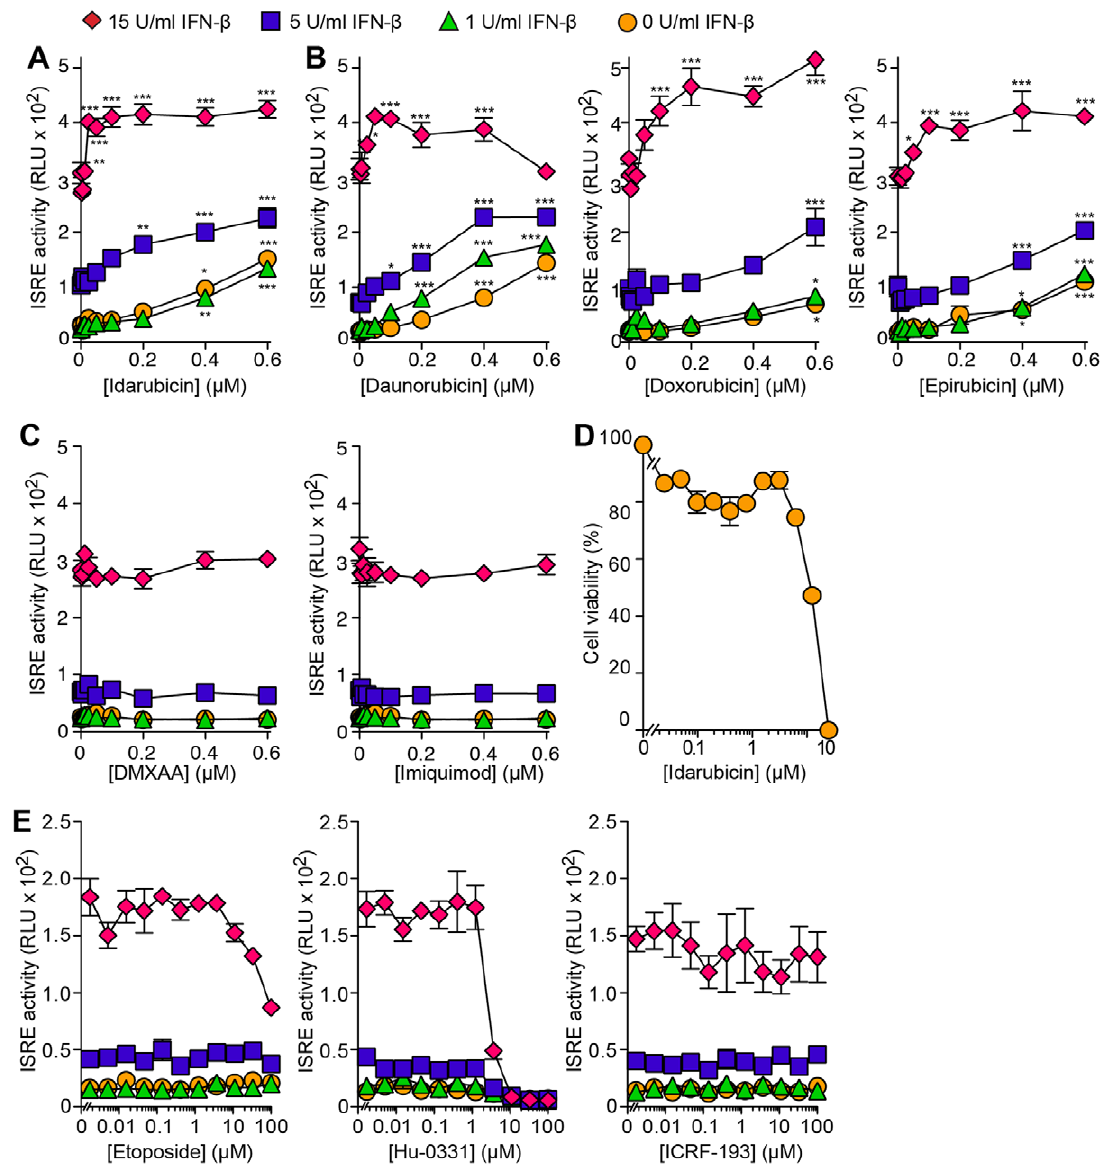
Figure 5. Validation and specifcity of idarubicin capacity for ISRE activation. (A) Idarubicin concentration-response for ISRE activity without and with treatment with IFN- b (1, 5, and 15 U/ml). 2fTGH-ISRE-CBG99 cells were treated with idarubicin and IFN- b for 8 h. Overall significance for idarubicin dose P , 0.0001, IFN- b dose p , 0.0001, and Interaction p , 0.0001. The p-values for individual comparisons (versus control without idarubicin) are from Bonferroni post-tests from two-way ANOVA (idarubicin x IFN dose). Symbols: * p , 0.05, ** p , 0.01, *** p , 0.001. (B) Corresponding data for daunorubicin, doxorubicin, and epirubicin concentration-response for ISRE activity. (C) Corresponding data for DMXAA and Imiquimod concentration-response for ISRE activity. Overall significance for compound dose p=ns, IFN- b dose p , 0.0001, interaction p=ns. (D) Idarubicin toxicity determined using Alamar Blue metabolism assay. Cells were treated with drug for 12 h. (E) Etoposide, Hu-0331, and ICRF-193 (0– 100 m M) concentration-response for ISRE activity without and with IFN- b (1, 5, and15 U/ml). Overall significance for ICRF-193 dose p=ns, IFN- b dose p , 0.0001, interaction p=ns; for Etoposide and HU-0331 dose, there is a significant inhibitory effect on ISRE activity, p , 0.0001, IFN- b dose p , 0.0001, interaction p , 0.0001.